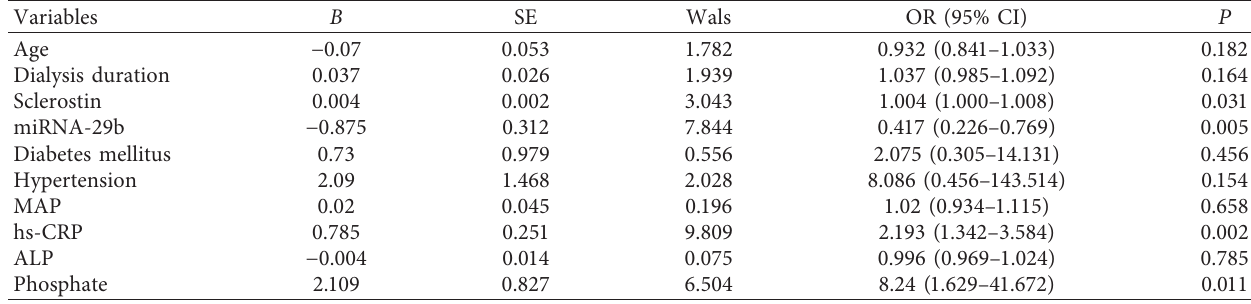
Table 2: Multivariate logistic regression model of risk factors for CAC in MHD patients.